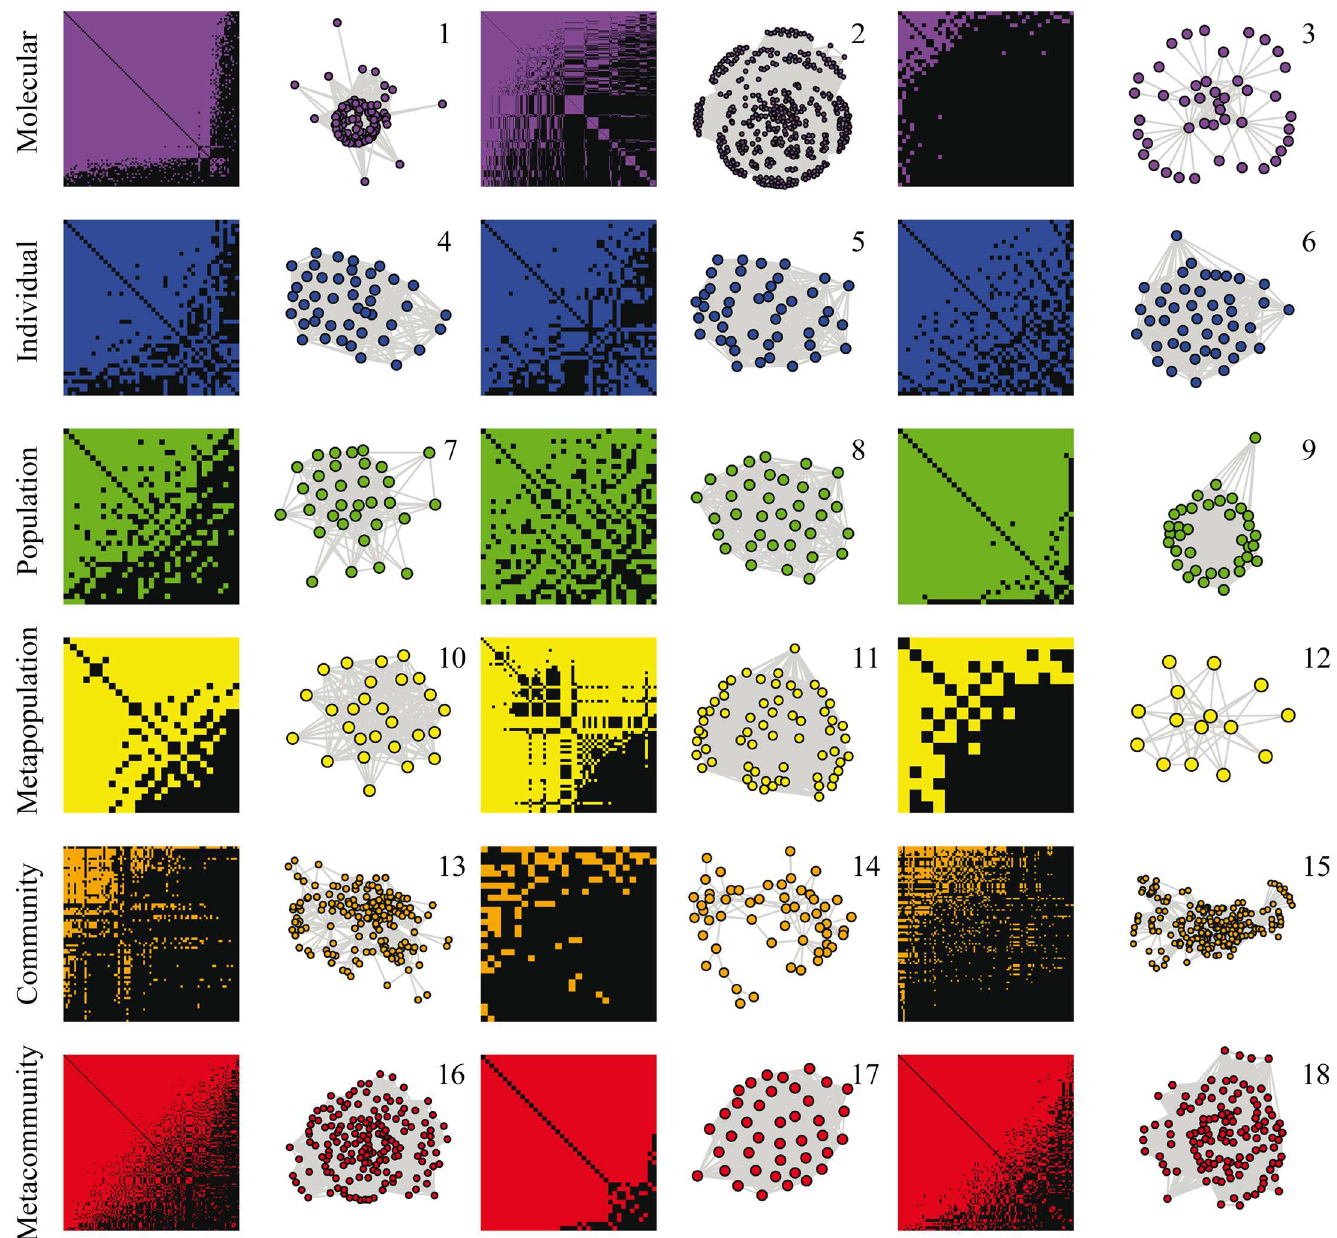
Fig 2. Adjacency matrices and network representation of 18 empirical biological systemsacross six organization levels. Molecularlevel: (1) yeast spliceosome protein-protein network, (2) C . elegans genetic network, (3) yeast nuclear exosome protein-protein network. Individuallevel: network representation of humancrania in (4) men, (5) women and (6) men in Europe. Populationlevel: social networks of (7) Guiana dolphins( Sotalia guianensis ), (8) bottlenosedolphins( Tursiopstruncatus ) and (9) spotted hyenas ( Crocutacrocuta ). Meta-population level: genetic differentiation among populations of (10) frogs ( Pelophylaxnigromaculatus ), (11), humans, and (12) house sparrows ( Passerdomesticus ). Community level: food webs in coastal habitats, (13) Mangroveestuary, (14) Narragansett Bay, and (15) Florida Bay. Meta-community level: co-occurrence of reef fish species in sites, groupedby (16) taxon (genera),and two functionalgroup schemes, (17) length and diet and (18) length, diet, mobility and school size. Matrices represent binaryversions of the originalweightednetworks, in which colored cells denote presenceof link betweenelementsof the network, and black cells denote link absence.We used a successive thresholdanalysis(see Methods) to create binary versions of the weightednetworks(for a similar approachsee [26]); in this figure, we considered the versionthat maximized nestedness. Matrices were orderedby row and column totals for improvevisualizationof nested patterns, but the order does not affect the calculationof nestedness (see